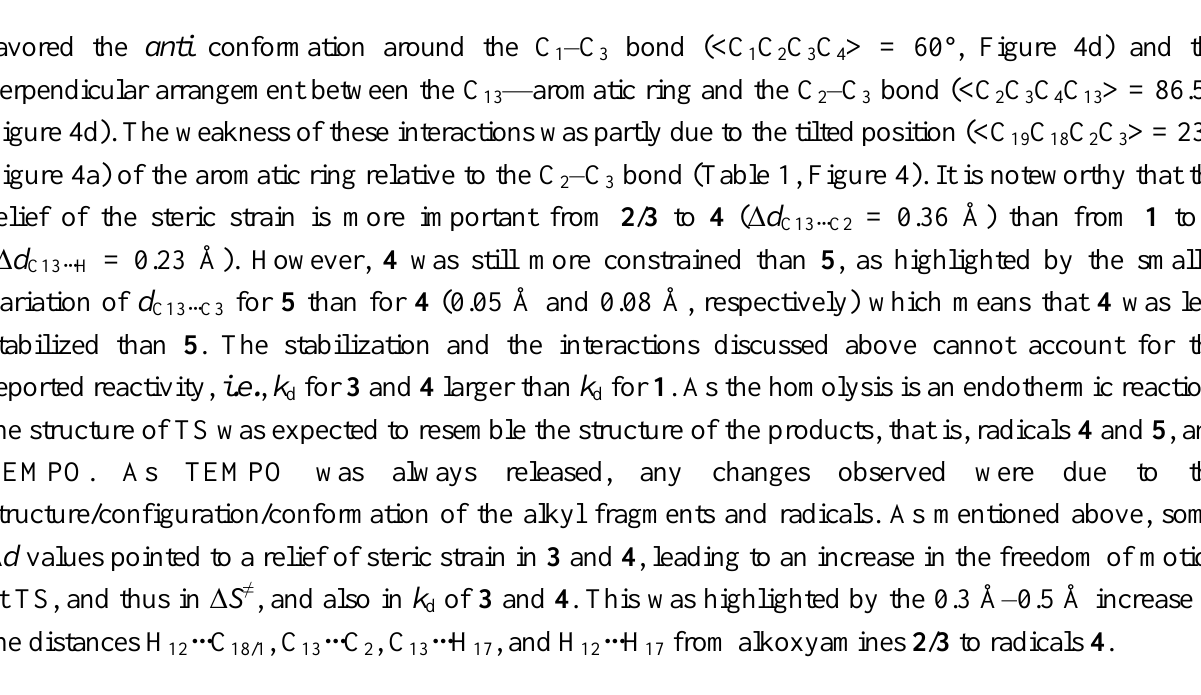
Figure 4. Newman's projections for various conformations for the alkyl radical: (a) along  SOMO interaction; (c) along the C4···C2 axis; (d) along the the C3–C4 bond; (b)  * C–C C3–C2